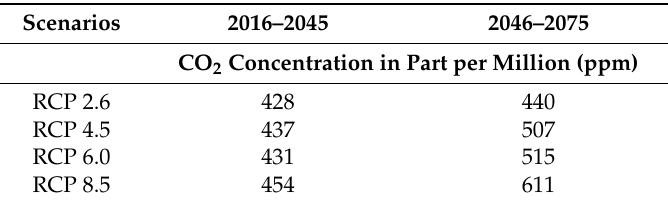
Table 3. Variable initial carbon dioxide concentration used for SWAT simulation under different emission scenarios